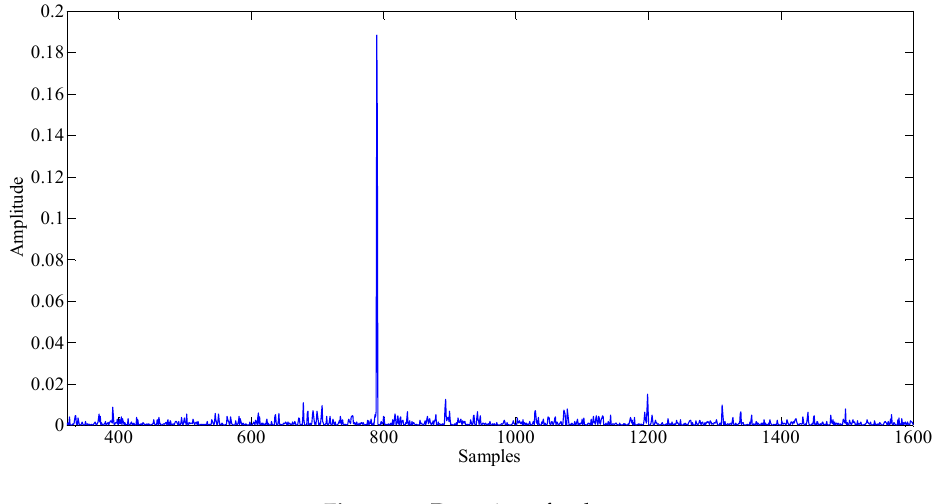
Figure 10. Detection of pulse.